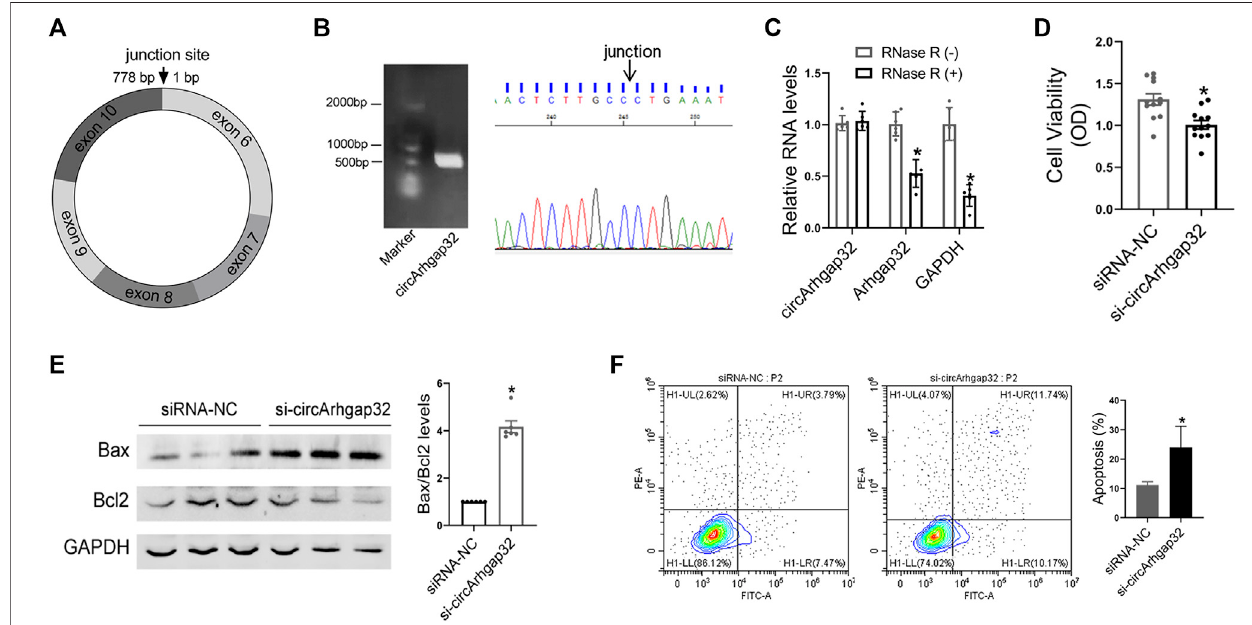
FIGURE 6 | Silencing of circArhgap32 promotes cardiomyocytes apoptosis. (A) Schematic illustrating the structure of circSnx5. (B) CircArhgap32 transcript was validated by Sanger sequencing. (C) Total RNA was digested with or without RNase R, followed by qRT-PCR measurements of circArhgap32, Arhgap32 and GAPDH; * p < 0.05 vs. RNase R ( − ). (D) Cell viability was detected in si-Arhgap32 or siRNA-NC treated HL-1 cells; * p < 0.05 vs. siRNA-NC. (E) Western blot for Bax and Bcl2 expression in si-Arhgap32 or siRNA-NC treated HL-1 cells; * p < 0.05 vs. siRNA-NC. (F) Cell apoptosis was detected by fl ow cytometry; * p < 0.05 vs. siRNA-NC.